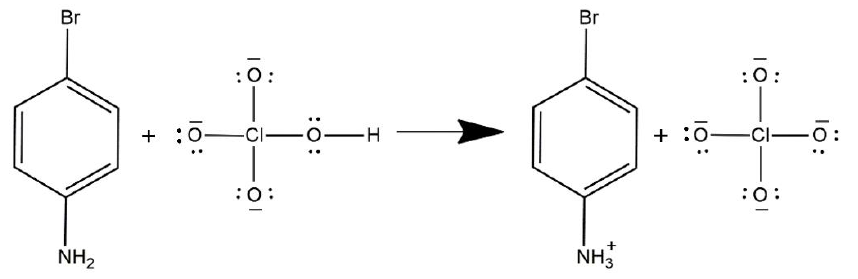
Figure 1. Reaction scheme of